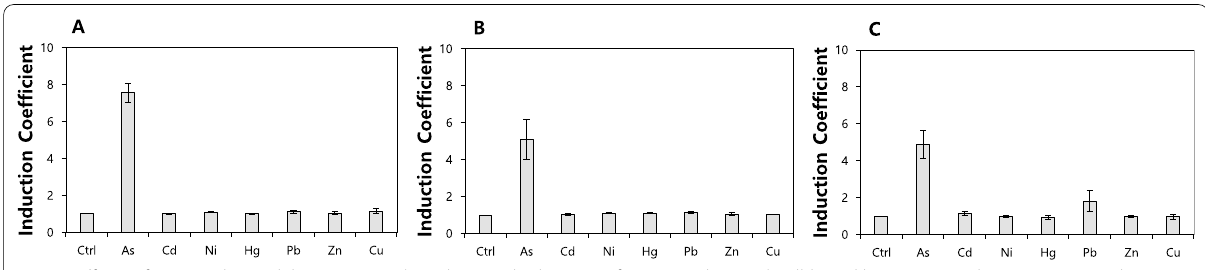
Fig. 1 Effects of copA and zntA deletions in E. coli on the metal selectivity of ArsR WT. The E. coli cell-based biosensors with ArsR WT as regulatory proteins were exposed to 5 µM metal(loid) ions including As(III), Cd(II), Ni(II), Hg(II), Pb(II), Zn(II), and Cu(II). The expression levels of eGFP upon metal(loid) exposure are represented as induction coefficient values. A E. coli-arsR , B E. coli-arsR/copA , and C E. coli-arsR/zntA were used as host cells for the